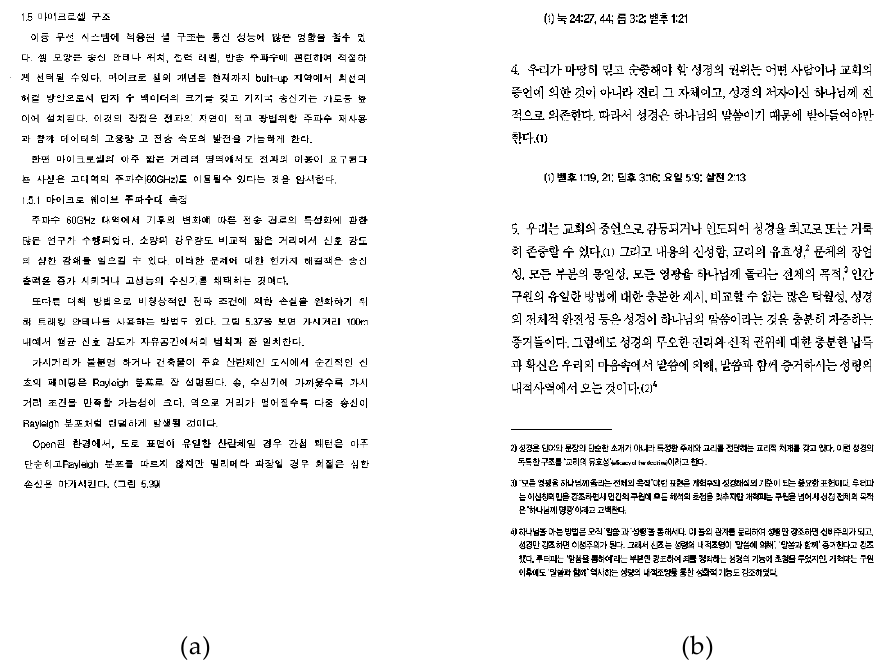
Figure 8. Binary Korean text used for simulation. ( a ) Hangeul-1 document, ( b ) Hangeul-2 document